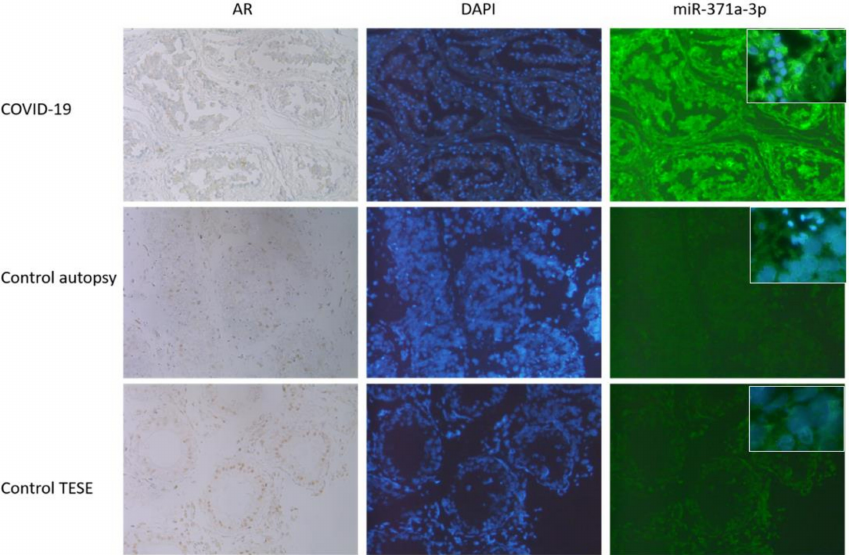
Figure 4. IHC followed by miR-371a-3p in situ PCR was performed. As it can be seen, those samples (controls, autopsy and TESE) showing high AR levels (here seen in brownish coloration of the nuclei, 40 × ) the miR-371a-3p expression is reduced (FITC staining right row, 40 × , inserts 63 × ). DAPI staining was included to visualize the nuclei. In COVID-19 samples were the AR levels were reduced (nuclei appears blue, first row) the miR-371a-3p was significantly upregulated (last row). Here, results out of three independent experiments are